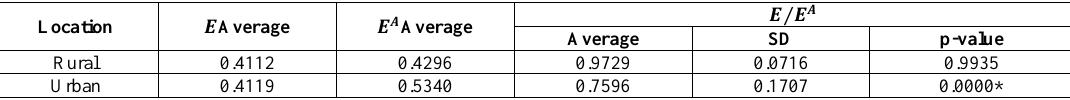
Table 6. The average impact of location factor and its significance.